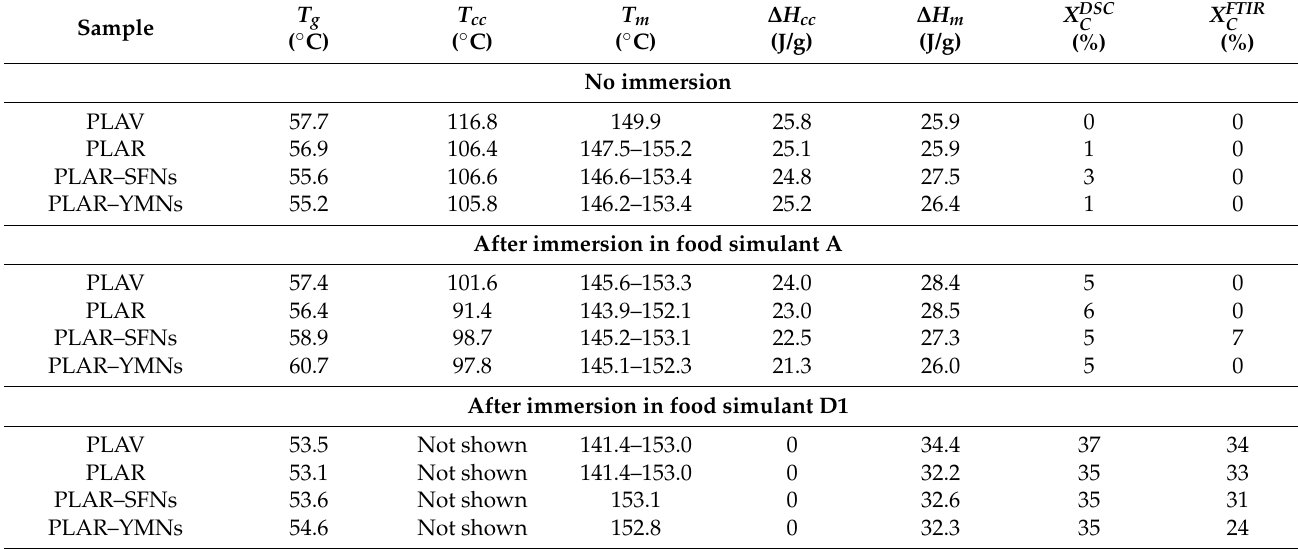
Table 2. DSC first heating results and FTIR crystallinity degree of the different